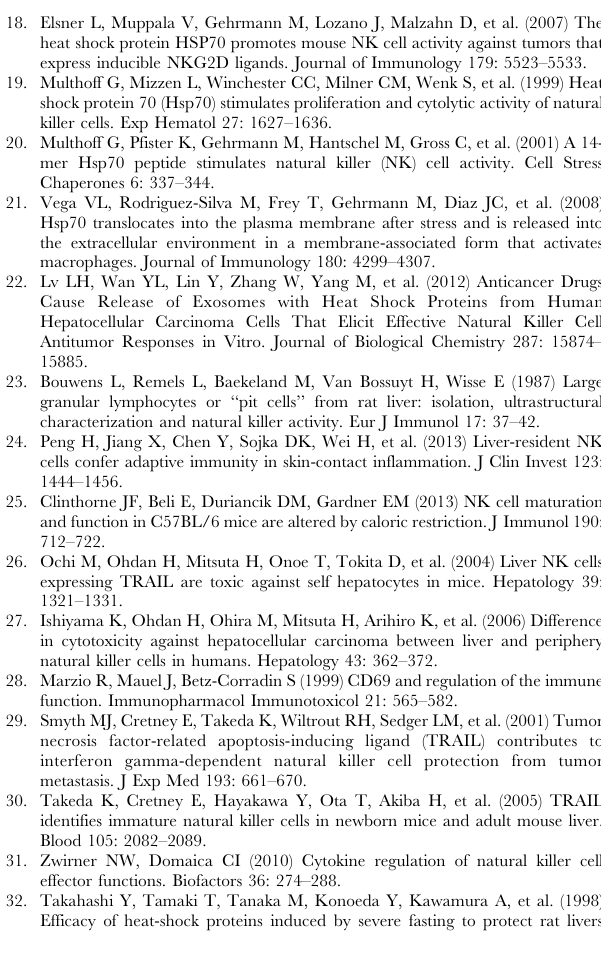
marrow, and (G) blood. Data were analyzed using the independent samples T test; *p , 0.05. (TIF) Figure S2 Physiological characteristics of the fasted mice. (A) Mouse body weight was measured every day during the fasting period. (B, C) Liver weight and ratio of liver:body weight were determined on the day of sacrifice. Lymphocytes from (D, E) the liver, (F) spleen, (G) bone marrow, and (H) blood from fed and fasted mice were counted using a hemocytometer; average numbers plus standard deviation are shown. The difference between groups was analyzed using the independent samples T test; * p , 0.05; ** p , 0.01.